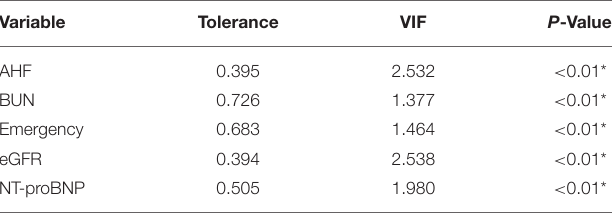
TABLE 4 | Multivariate Cox regression of 180-day unplanned readmission in patients with CHF.